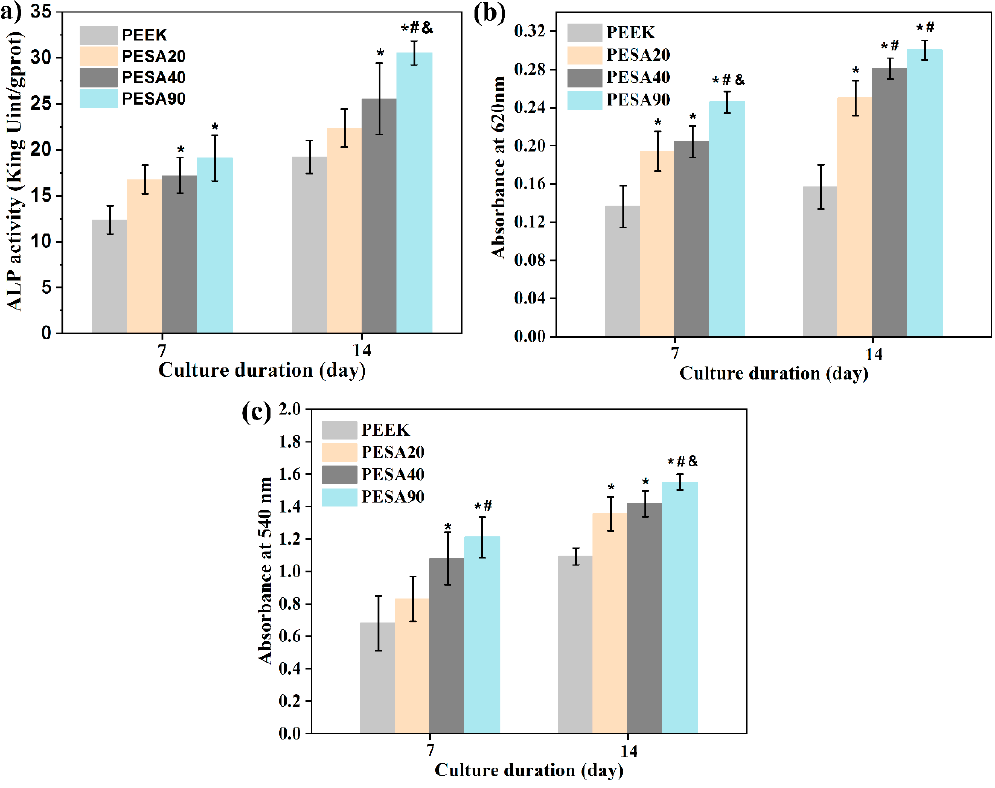
Figure 7. The quantitative results of ( a ) ALP activity, ( b ) ECM mineralization, and ( c ) COL secretion at different time points (days 7 and 14). Statistically significant differences were indicated by * p < 0.05 compared with the PEEK, # p < 0.05 compared with the PESA20, and & p < 0.05 compared with the PESA40. All data represent the mean value ± standard deviation ( n = 4 per group).